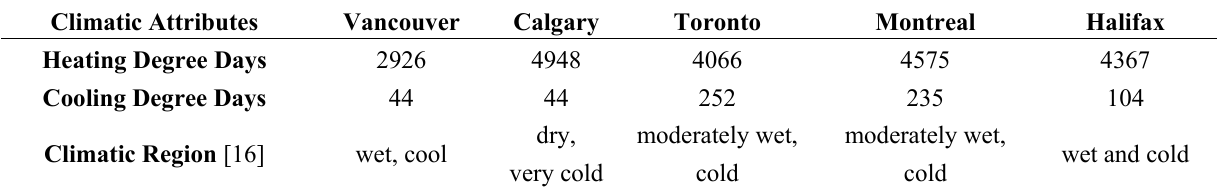
Table 4. Average annual heating and cooling degree days in Canadian cities (1971–2000) [15]. Climatic Attributes Vancouver Calgary